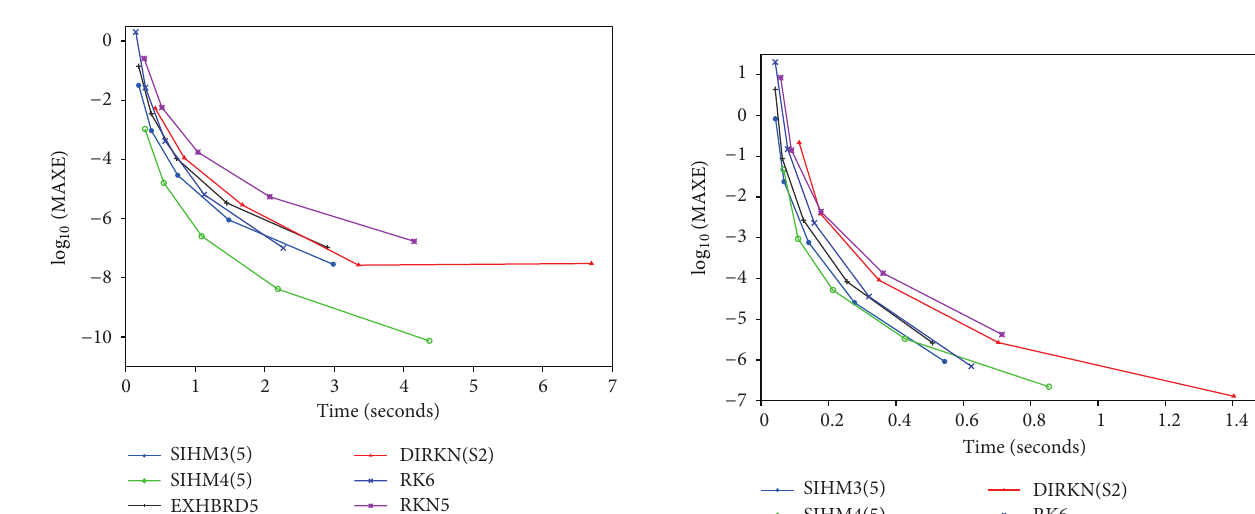
Figure 9: The efficiency curves for SIHM3 (5) and SIHM4 (5) methods for Chawla and Rao problem with ℎ = 0.125/2 𝑖 , 𝑖 = 3, ...,7 .